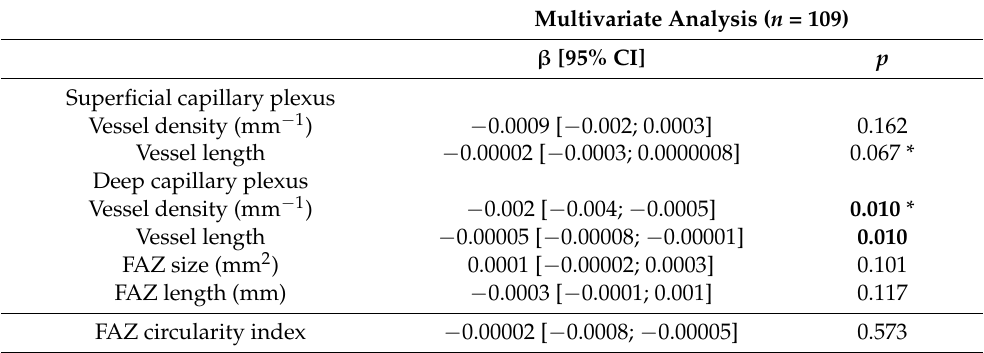
Table 2. Association between retinal vascular parameters and Coronary Artery Calcium score in familial hypercholesterolemia group eyes.